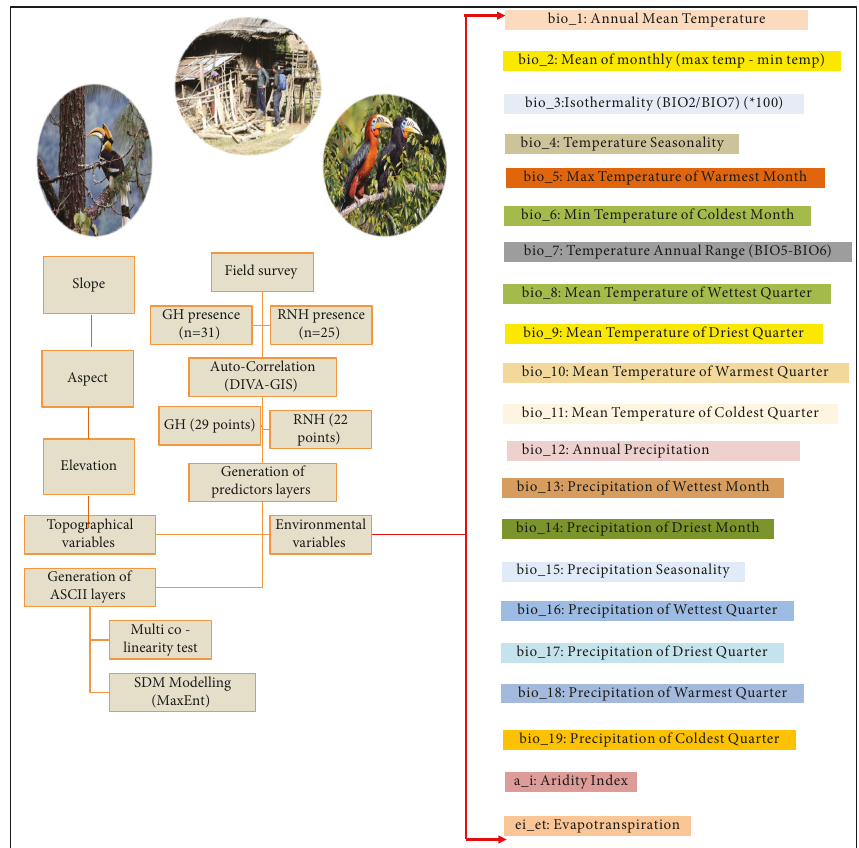
Figure 2: Flow chart of the methodology